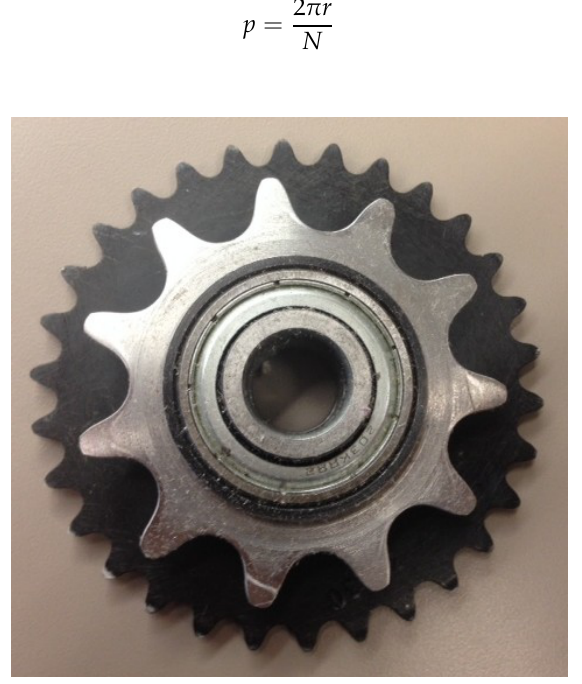
Figure 2. Tooth gears used as impactors including the 11-tooth (silver) and 30-tooth (black) gears.